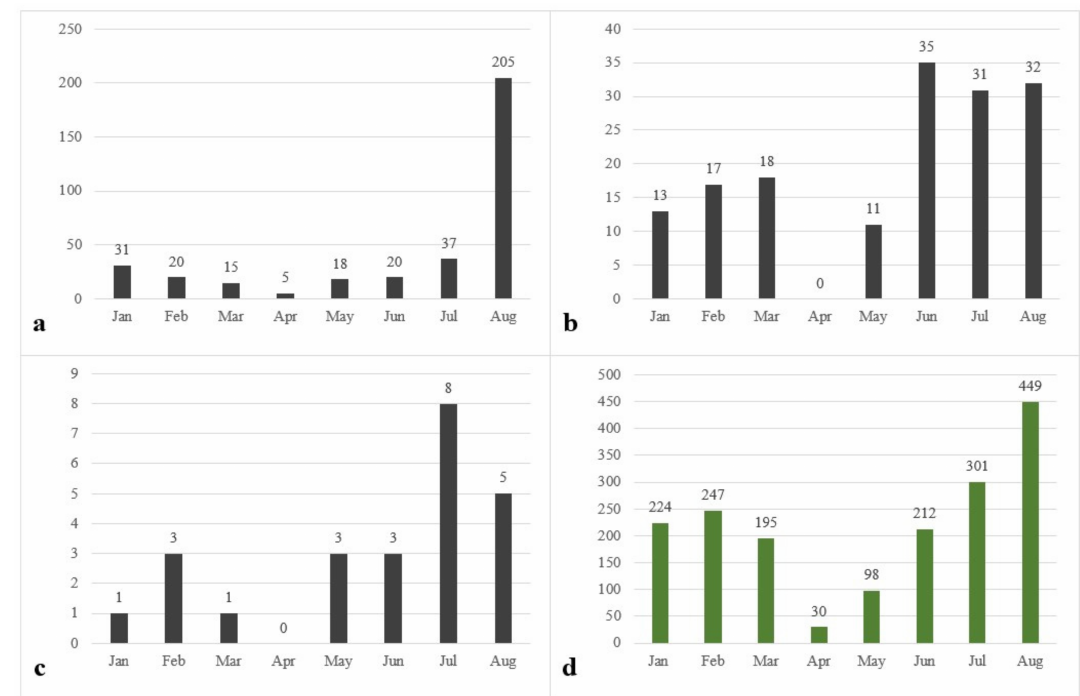
Figure 3. The number of posts per month for parks Cismigiu ( a ), Tineretului ( b ), Pacii ( c ) and the total number of parks ( d ).